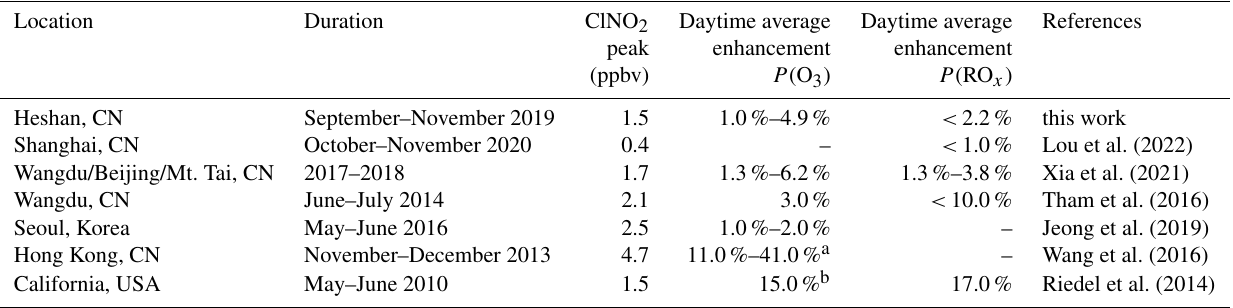
Table 6. The summary of impacts of ClNO 2 on the next-day enhancement of ozone and radical production based on the box model that was constrained by field observations in previous literature.